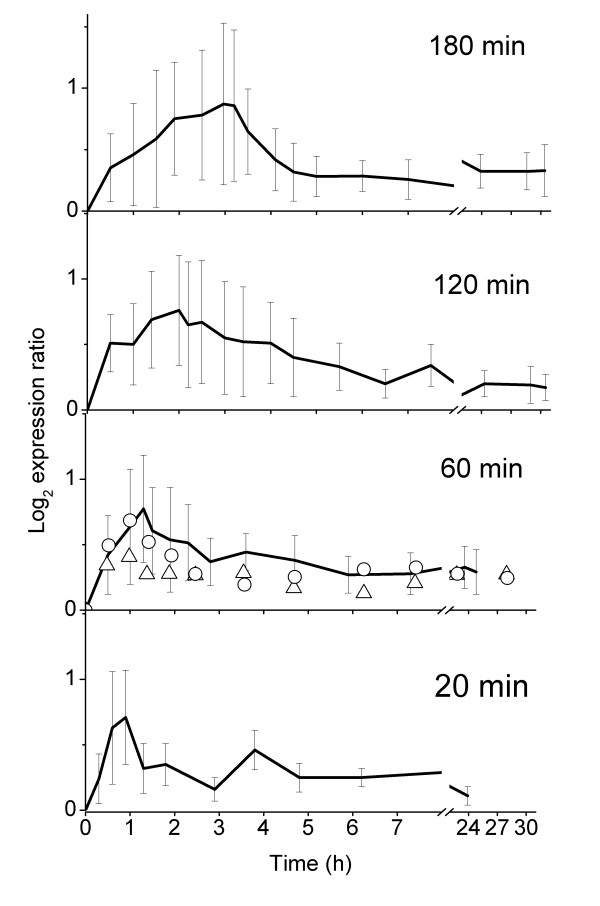
Average responses of 30 marker genes to anaerobic phases. In steady state phase of a chemostat culture (D = 0.03 h-1, pH 5) the air supply was replaced with N2 for 20, 60, 120 and 180 min. Curves show the average variation of the entire marker gene set (Table 1) in each sample point from the 0 h sample (initial steady state). In the figure for 60 min, circles show the corresponding average response for 60 min without either air or medium feed and triangles show the average response to 60 min without medium feed, but with air. The average variation in the responses between different marker genes is indicated by the bars.